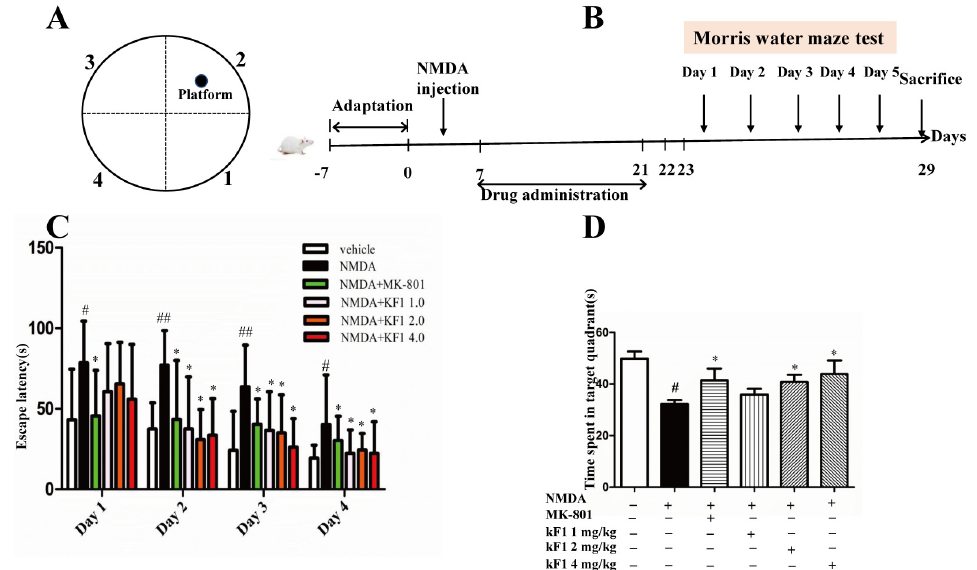
Figure 5. The spatial learning and memory of KF1 -treated mice in the MWM test. ( A ) The MWM schematic. ( B ) The MWM test design. ( C ) The latencies after 4 days of training trials. The data are expressed as means ± SEM ( n = 10–12); # p < 0.05, ## p < 0.01 versus vehicle group; * p < 0.05 versus NMDA group. ( D ) The retention time in the target quadrant. The data are expressed as means ± SEM ( n = 10-12); # p < 0.05 versus vehicle group; * p < 0.05 versus NMDA group.